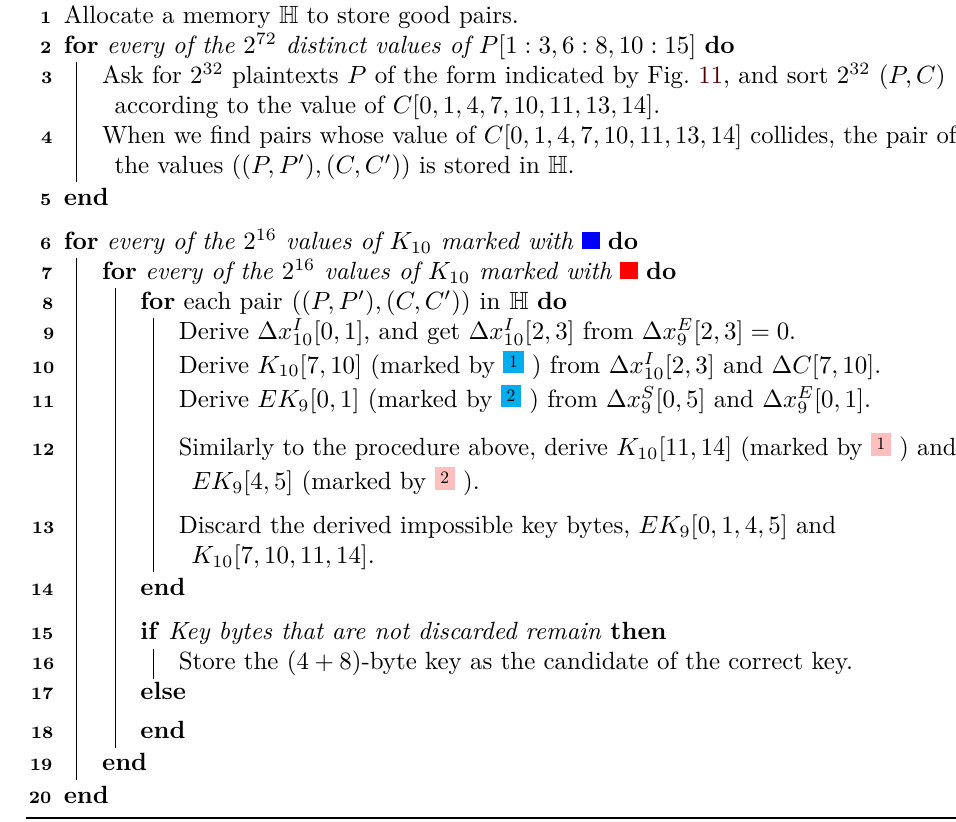
Algorithm 3: Impossible differential attack on Dual-AES-PRF 8 , 2 with one struc-